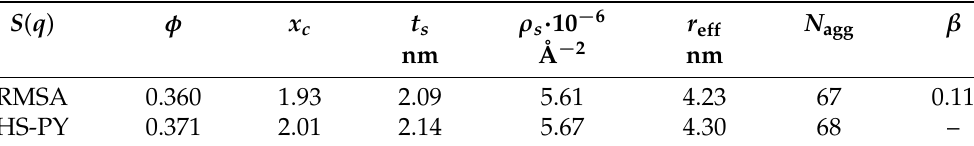
Table 7. Parameters extracted from SANS model fits (core-shell ellipsoid form factor + RMSA or PY structure factor) of mixed SDS/BrijL23 surfactants in D 2 O at 20.0°C with a total surfactant concentration c =127mM and a mixing ratio X =0.32.